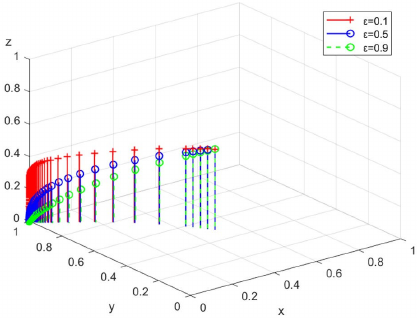
Figure 8. The path under different levels of public concern.